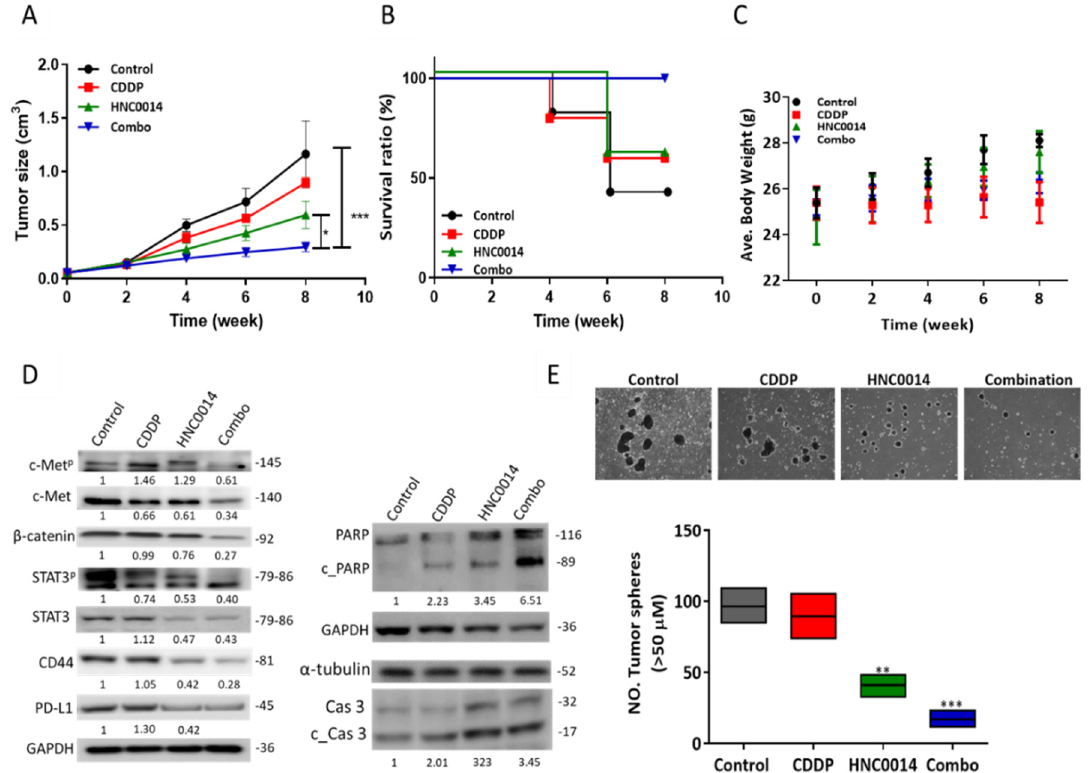
Figure 5. HNC0014 treatment improved cisplatin sensitivity and suppressed tumorsphere-initiated tumor growth in vivo. An SAS tumorsphere-bearing mouse model was established to evaluate HNC0014 ′ s antitumor efficacy. An average tumor volume versus time curve ( A ) shows that HNC0014 treatment significantly delayed tumor growth. The Kaplan–Meier survival curve ( B ) shows a higher overall survival ratio of animals treated with HNC0014 alone or in combination with cisplatin compared to the control counterparts. ( C ) HNC0014 treatment caused no significant changes in the body weights of the animals. ( D ) Western blots from tumor samples of HNC0014 and the combination groups revealed decreased expressions of c-Met / STAT3 / CD44 / PD-L1 and β -catenin, while increased expression levels of apoptotic markers PARP and caspase-3 (Cas) and their cleaved forms PARP (c_PARP) and Cas3 (c_Cas3), respectively (right panel). ( E ) In vitro tumorsphere-forming assay showed that tumor cells harvested from HNC0014 and the combination groups formed significantly lower numbers of tumorspheres compared to the cisplatin (CDDP) and vehicle control groups. Magnification 4X. ** p < 0.01, *** p <